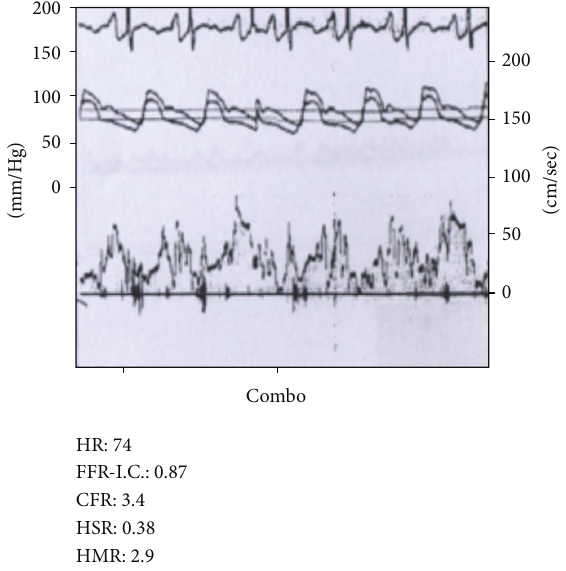
Figure 2: Coronary flow reserve (CFR) tracing during intravenous adenosine infusion prior to balloon directed occlusion revealing a value of 3.4 after IV adenosine 140 mcg/kg/min.